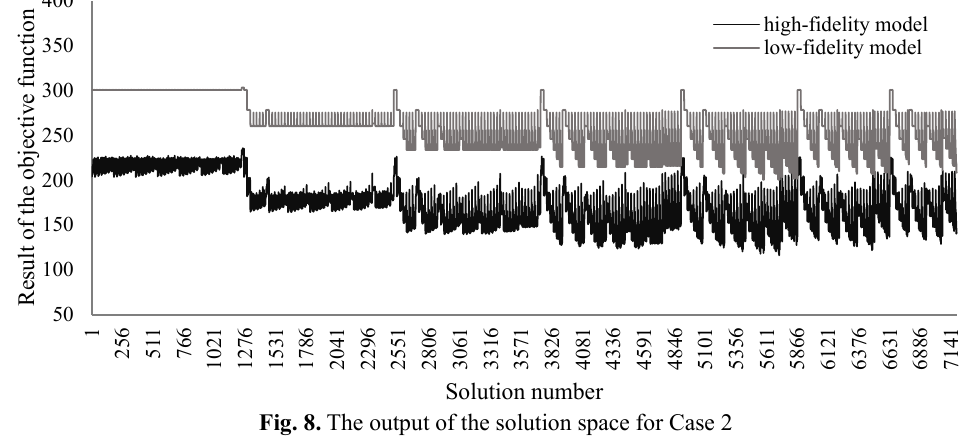
Fig. 8. The output of the solution space for Case 2